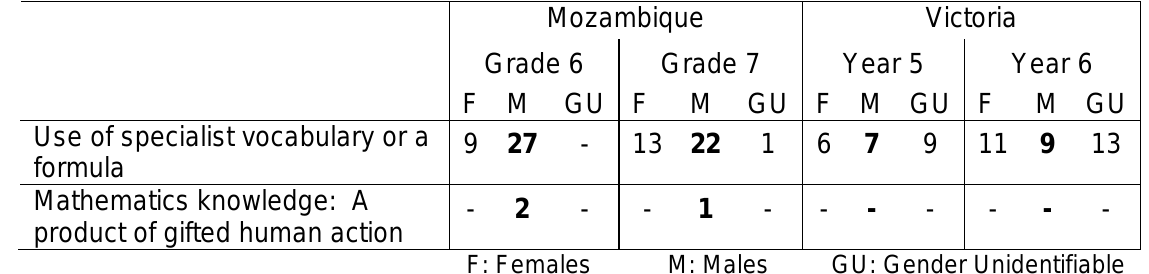
Table 6. Gender distribution among text features valuing ‘specialism’ in mathematics learning.